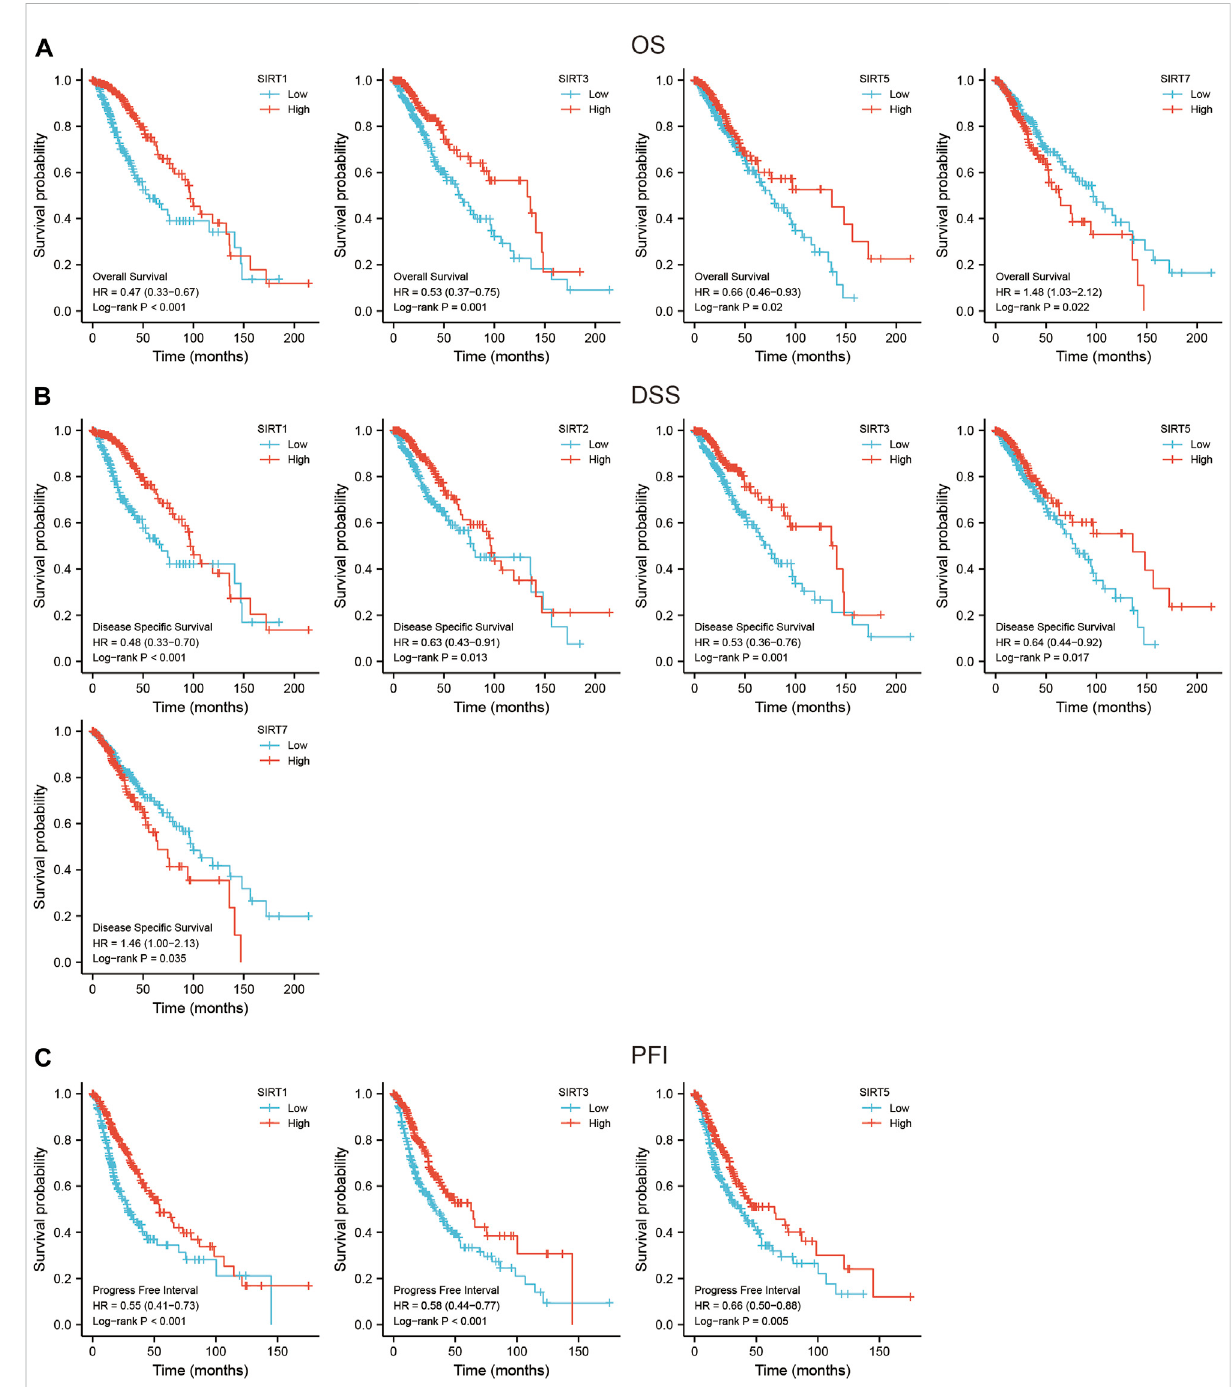
FIGURE 3 Prognostic value of SIRT genes in glioma. (A) SIRT family members associated with OS in glioma patients. (B) SIRT family members associated with DSS in glioma patients. (C) SIRT family members associated with PFI in glioma patients (* p < 0.05, ** p < 0.01, *** p < 0.001, ns: p >